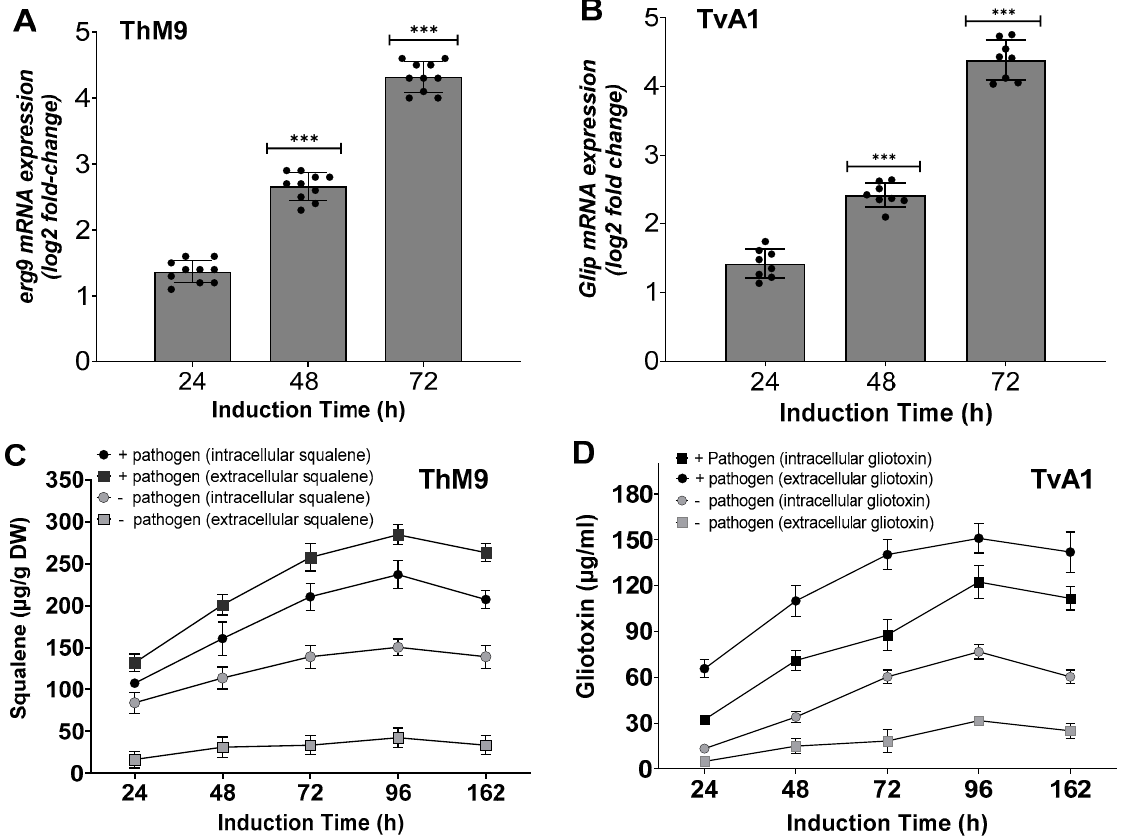
Figure 2. Induction of squalene and gliotoxin biosynthesis genes and metabolic level in ThM9 and TvA1 fungal isolates. ( A ) Expression of squalene biosynthesis enzymatic gene SQS1/ERG9 ( squalene synthase ). ( B ) Expression of gliotoxin biosynthesis core enzymatic gene GliP ( NRPS dioxopiperazine synthetase ). ( C ) Squalene level in ThM9 and ( D ) gliotoxin level in TvA1 upon confrontation with P. cubensis . Quantitative data represent the means ± SD (n = 12) of three independent experiments. The asterisks indicate represents a significant difference between treated samples compared to control (*** p ≤ 0.005). DW, dry weight.